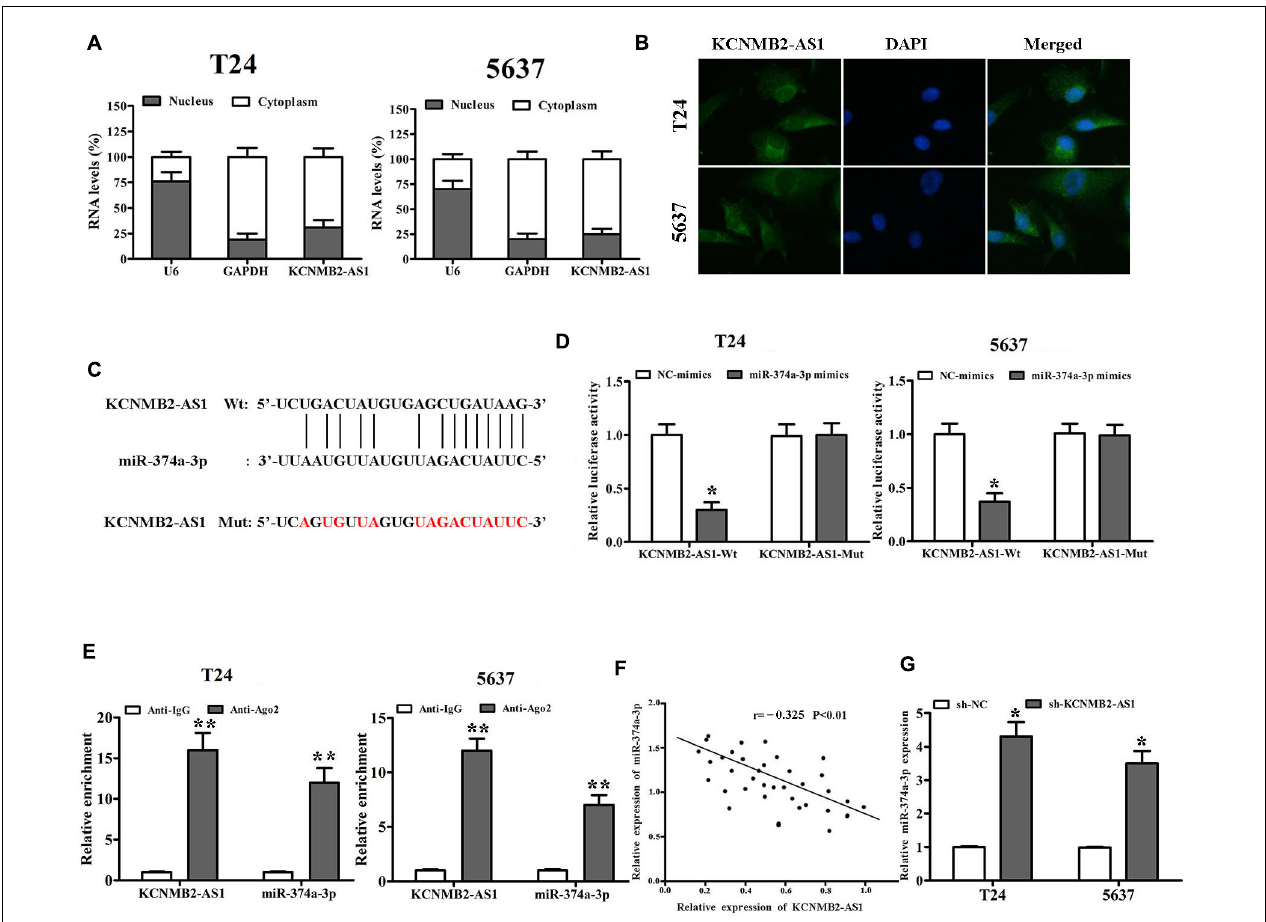
FIGURE 3 | KCNMB2-AS1 was a sponge for miR-374a-3p in BC. (A,B) Subcellular fractionation and RNA FISH assays ( × 400) were used to confirm that KCNMB2-AS1 was located mainly in the cytoplasm. (C) Binding sites between KCNMB2-AS1 and miR-374a-3p were predicted by starBase. (D,E) Luciferase reporter assay and RIP assay indicated that KCNMB2-AS1 could bind with miR-374a-3p. (F) Pearson correlation was conducted to explore the correlation between miR-374a-3p and KCNMB2-AS1 in BC tissues. (G) miR-374a-3p expression was increased after KCNMB2-AS1 knockdown. Data were showed as mean ± standard deviation. The experiment was repeated 3 times. * P < 0.05. ** P < 0.01.